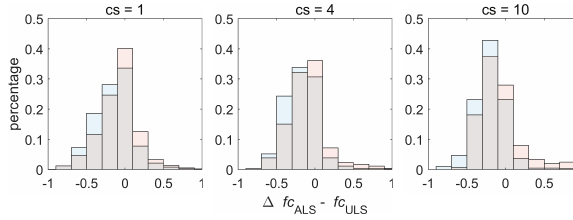
Figure 5. Relative histogram of differences between h 90 Figure 6. Relative histogram of differences between fc calculated from ULS data with regard to ALS data for raster cell calculated from ULS data with regard to ALS data for raster cell sizes ( cs ) of 1, 4, and 10 m, respectively. Bin widths are set to sizes ( cs ) of 1, 4, and 10 m, respectively. Bin widths are set to 1 m, differences are measured in [m]. Orange: site 1, blue: ∆ fc = 0.2, differences are measured in the unit of fc . Orange: site 2, gray: overlay of the histograms. site 1, blue: site 2, gray: overlay of the